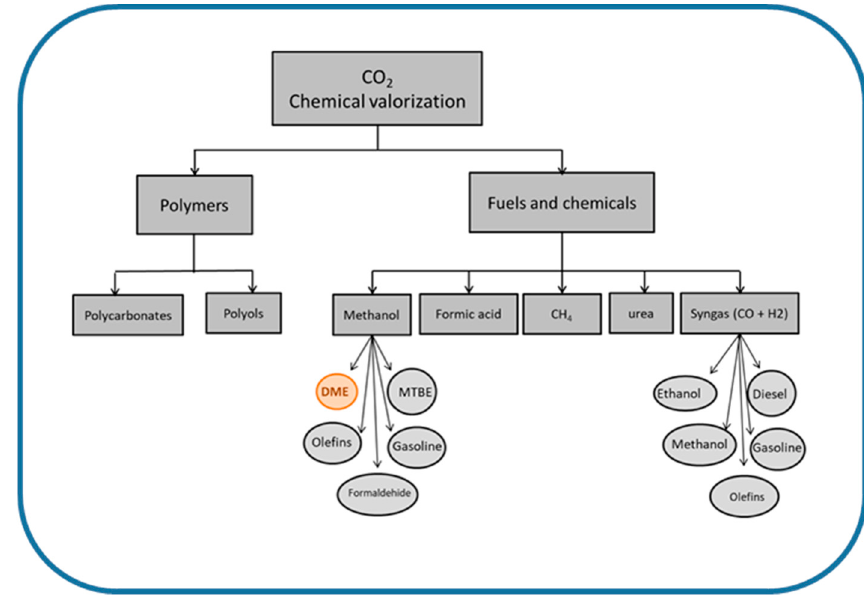
Figure 1. Main chemical valorization routes for CO 2 as feedstock.